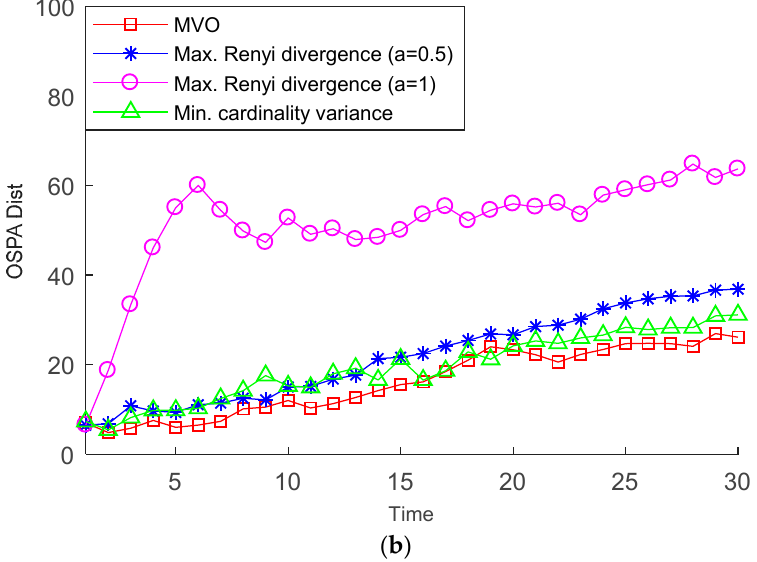
Figure 8. Mean OSPA error for different number of selected receivers: ( a ) S = 2; ( b ) S = 3.